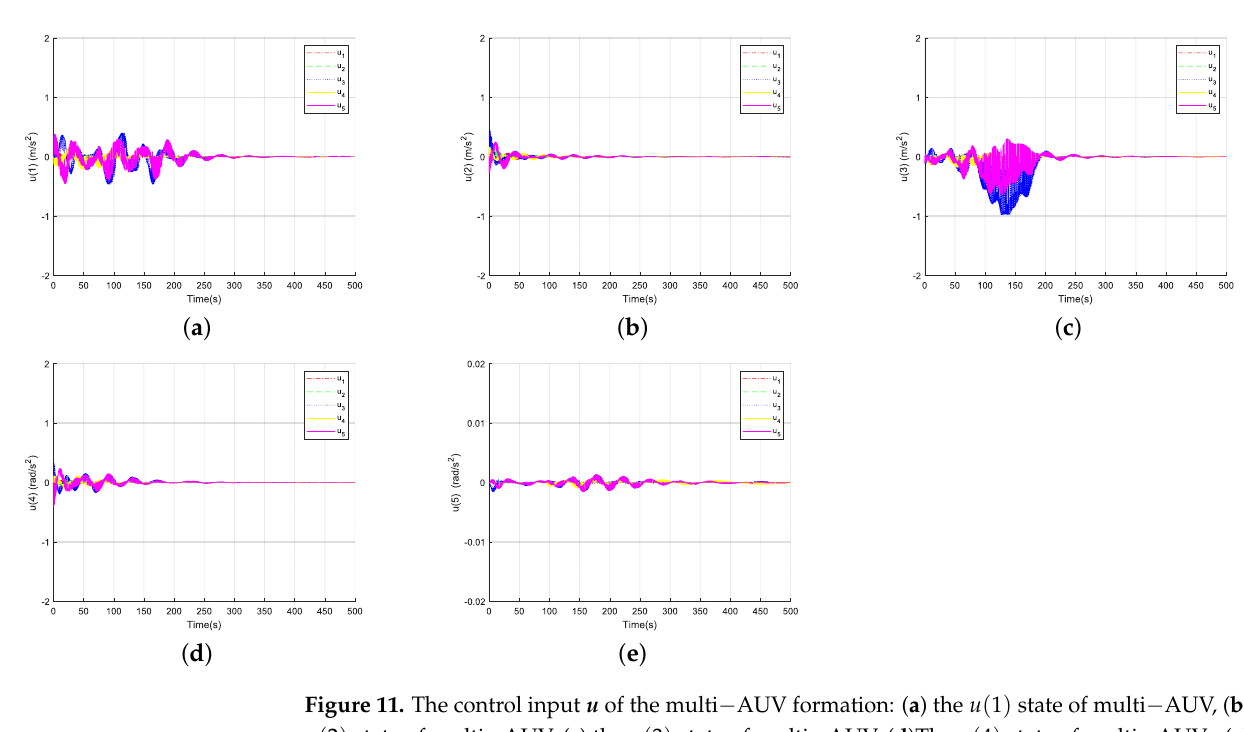
Figure 11. The control input u of the multi − AUV formation: ( a ) the u ( 1 ) state of multi − AUV, ( b ) the u ( 2 ) state of multi − AUV, ( c ) the u ( 3 ) state of multi − AUV, ( d )The u ( 4 ) state of multi − AUV , ( e ) the u ( 5 ) state of multi − AUV.